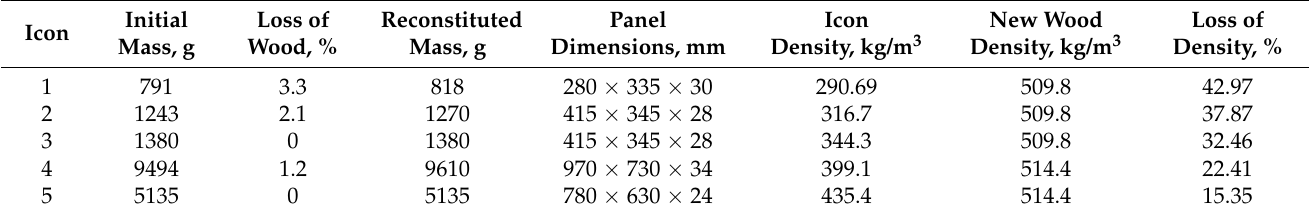
Table 1. Degree of degradation-fragility obtained by the density method.